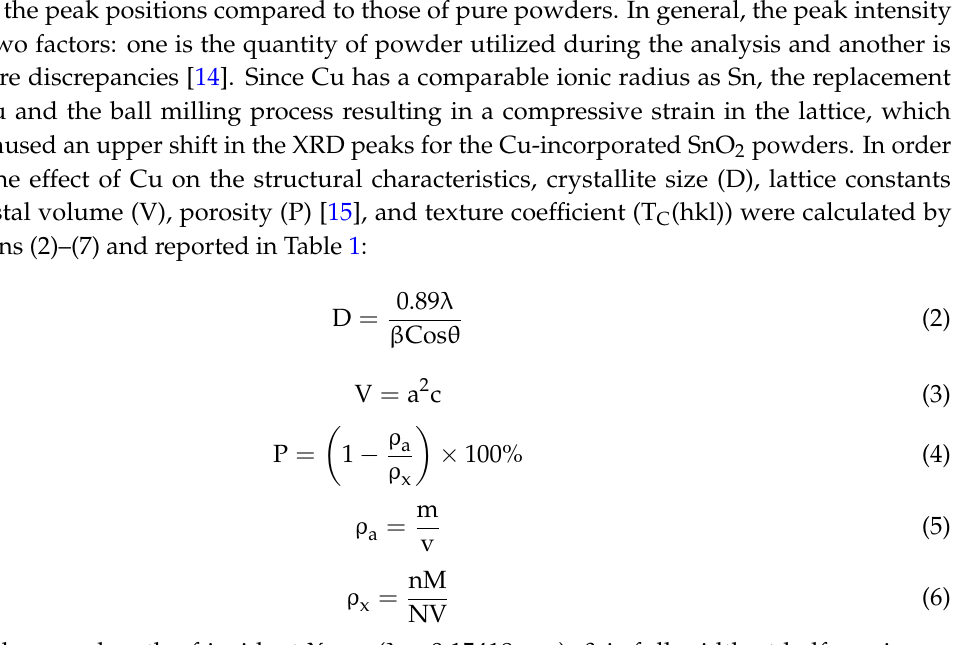
Table 1. Crystallite size (D), lattice constants (a and c), volume of the crystal (V), porosity (P), and texture coefficient (T C (101)) of the pure and Cu-incorporated SnO 2 nano-crystals.